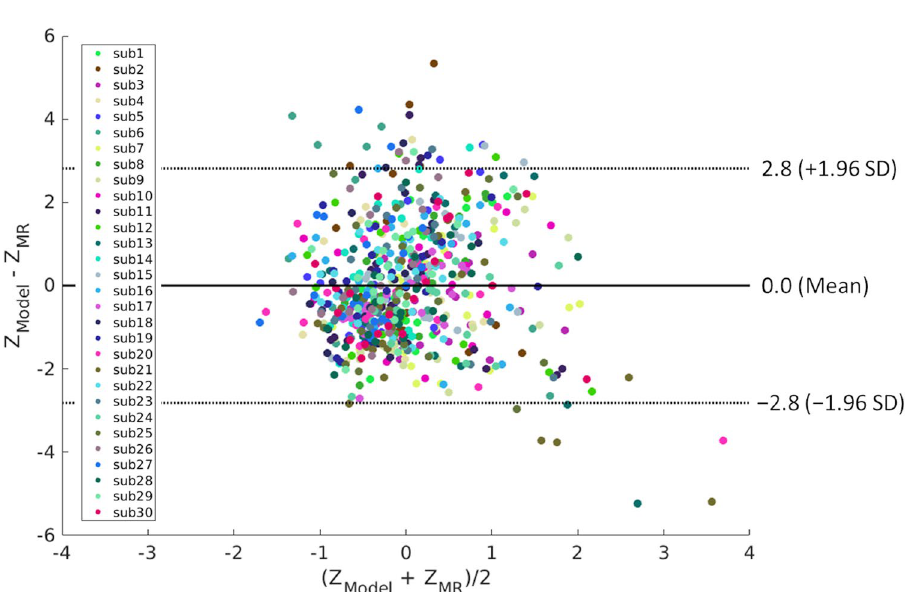
Figure 3. Bland–Altman plot demonstrating agreement between model-predicted and MR-measured temperatures for all subjects and 22 cortical and subcortical regions. Data points are color-coded by subject. Z model Z-scores of model-predicted brain temperatures, Z MR Z-scores of MR-measured brain temperatures, SD standard deviation, sub